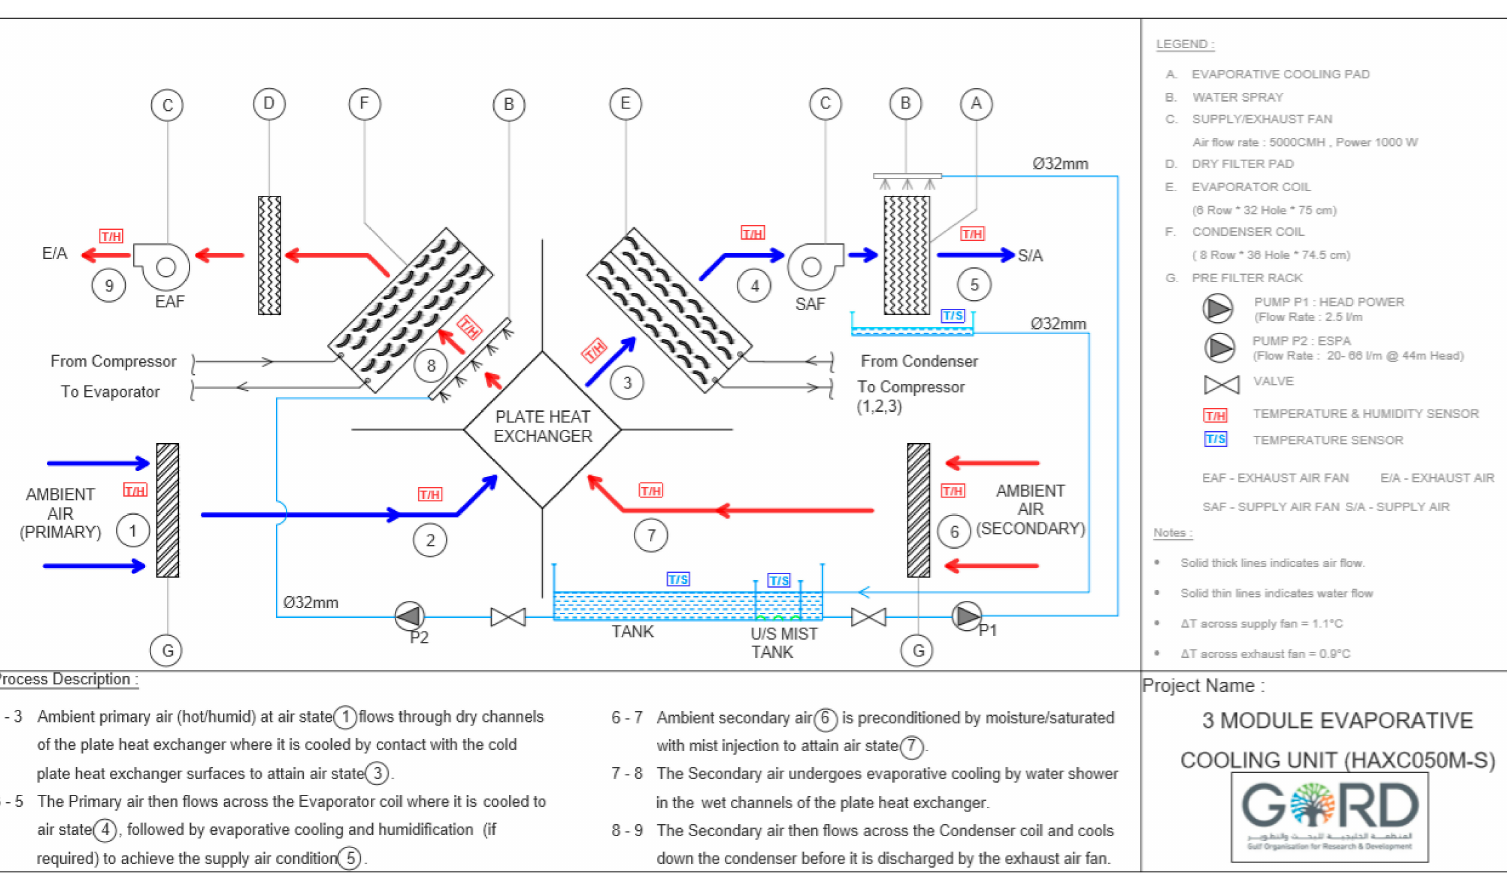
Figure 2. Schematic diagram of experimental test